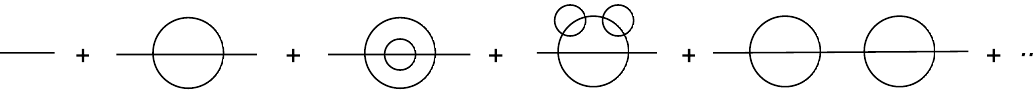
Figure 1 . The large- N limit of the SYK-like model of [41], like many tensor models, is dominated by \melon" graphs. Here we show several melonic contributions to the 2-point function. In general they may be generated iteratively using the basic building block shown in the second